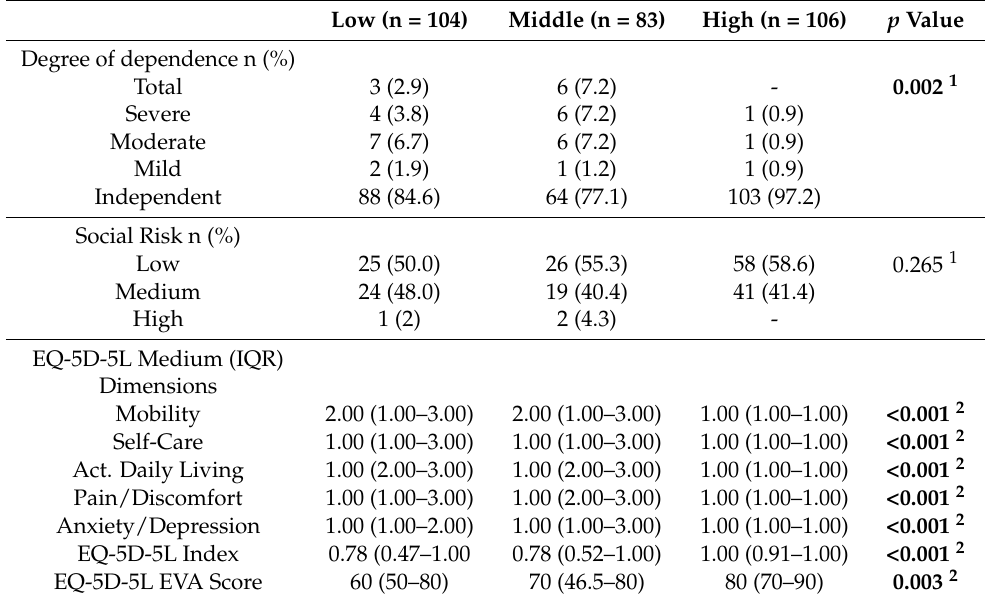
Table 5. Dependence, social risk, and quality of life based on the degree of acceptance of new